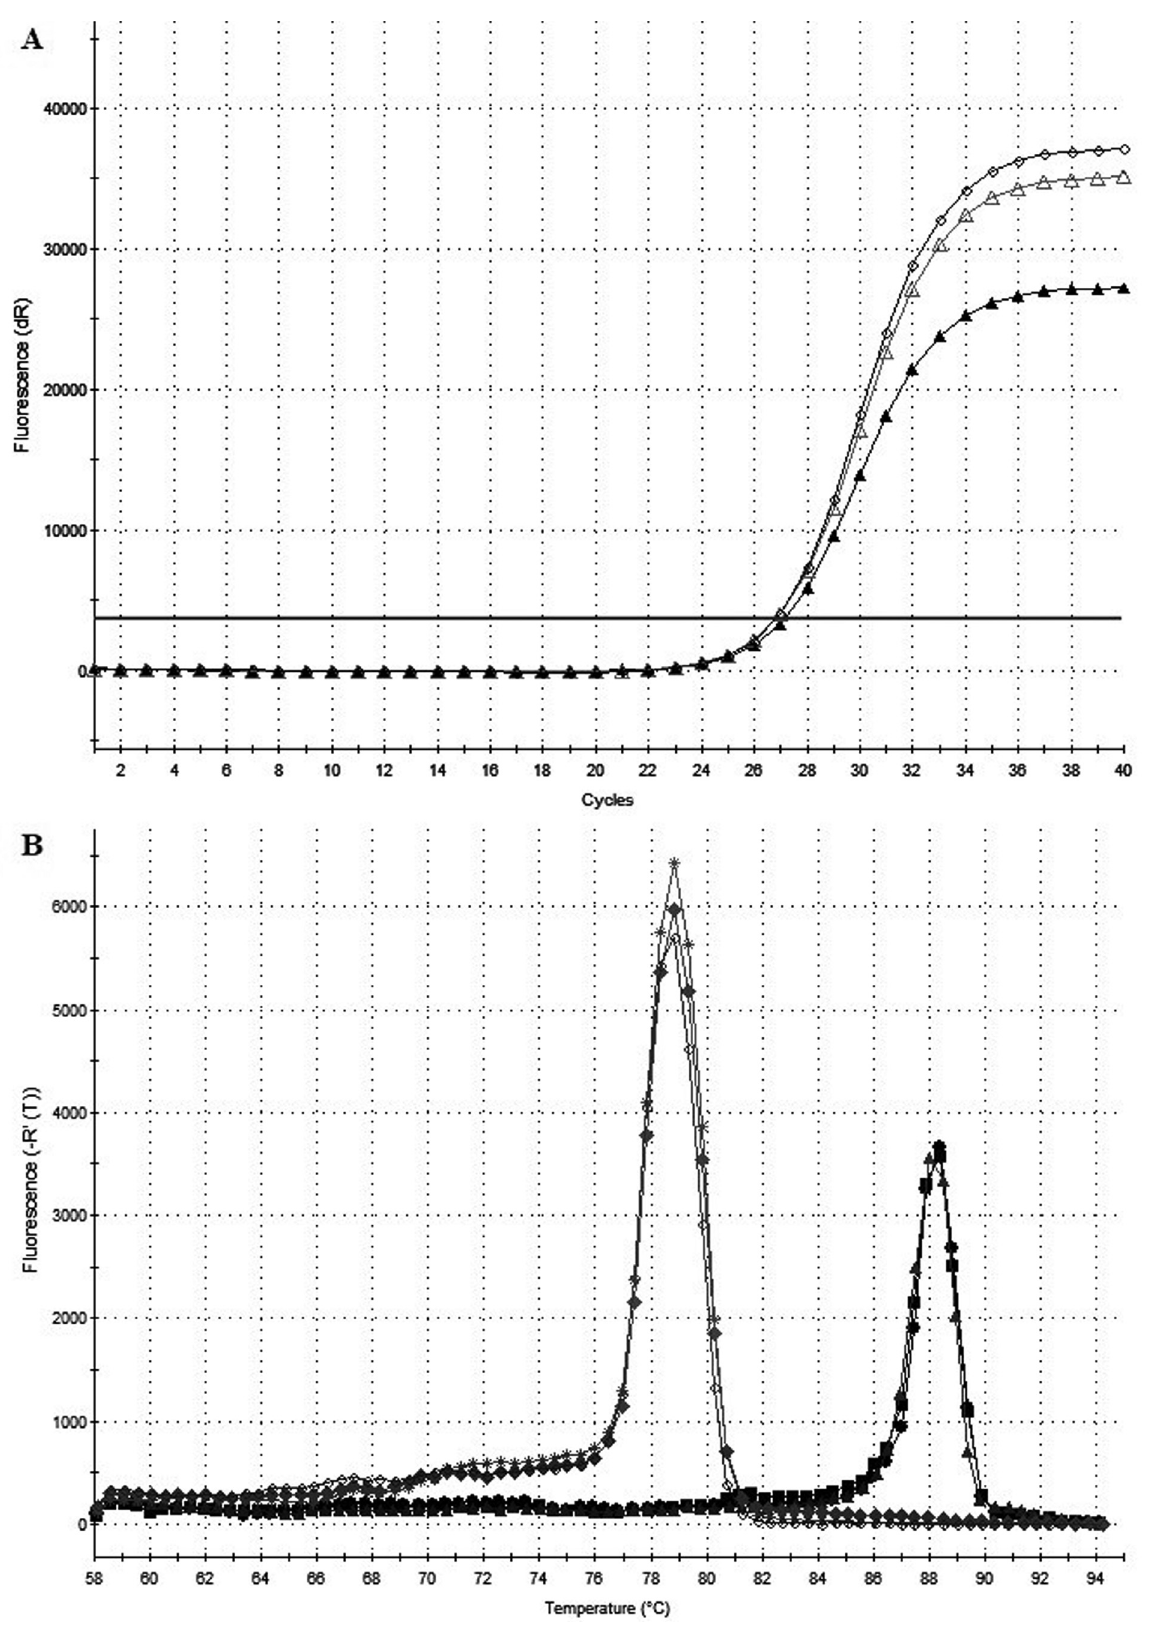
Figure1 -AmplificationplotofqPCRreactionforsampleswithfluorescencethreshold(A)andmeltingcurveofamplificationproducts(B).Themelting temperature (Tm) for the reference gene ACTB was 88 °C and for the ACVR2A gene was 79 °C. The samples were made in